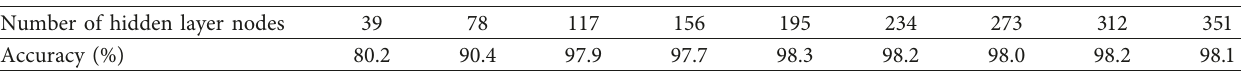
Table 4: Predictive accuracy of traditional Chinese musical instruments with different numbers of nerve nodes in one latent layer. Number of hidden layer nodes